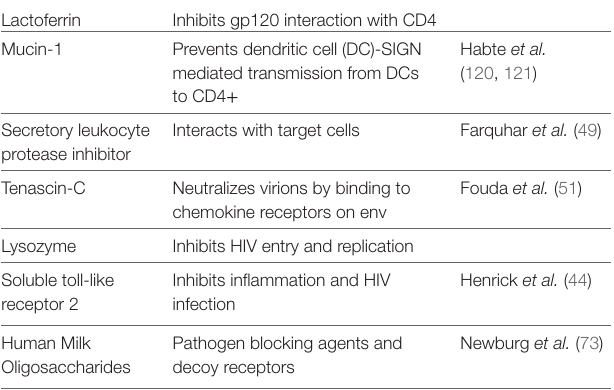
TABle 1 | Innate factors in human